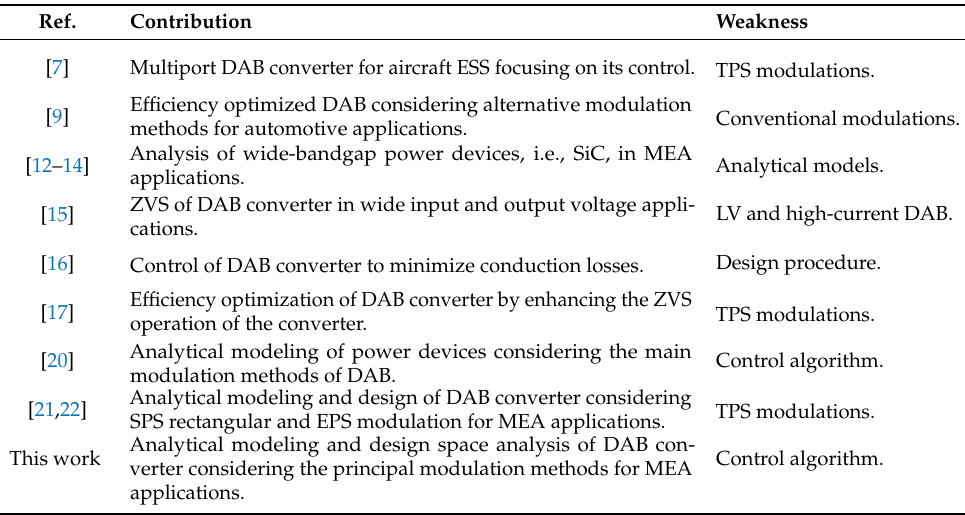
Table 1. Summary of literature contributions for DAB